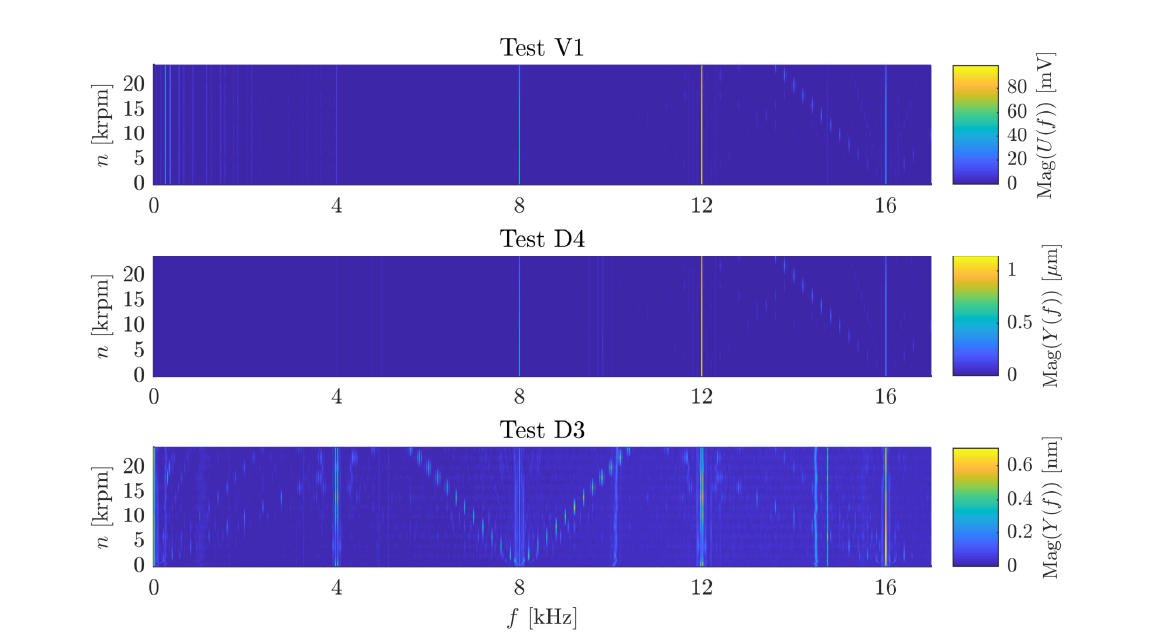
Figure 12. Frequency map: Test V1 , voltage measurement in configuration target coupled to machine tool table; Test D4 , displacement measurement in configuration target coupled to machine tool table; and Test D3 , displacement measurement in configuration measurement device galvanically separated from machine